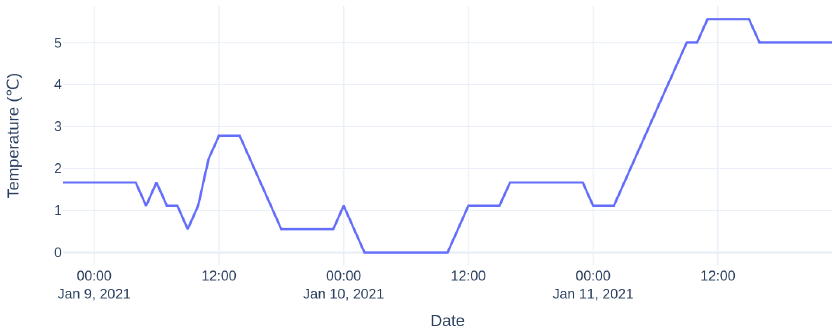
Figure 12. Ambient